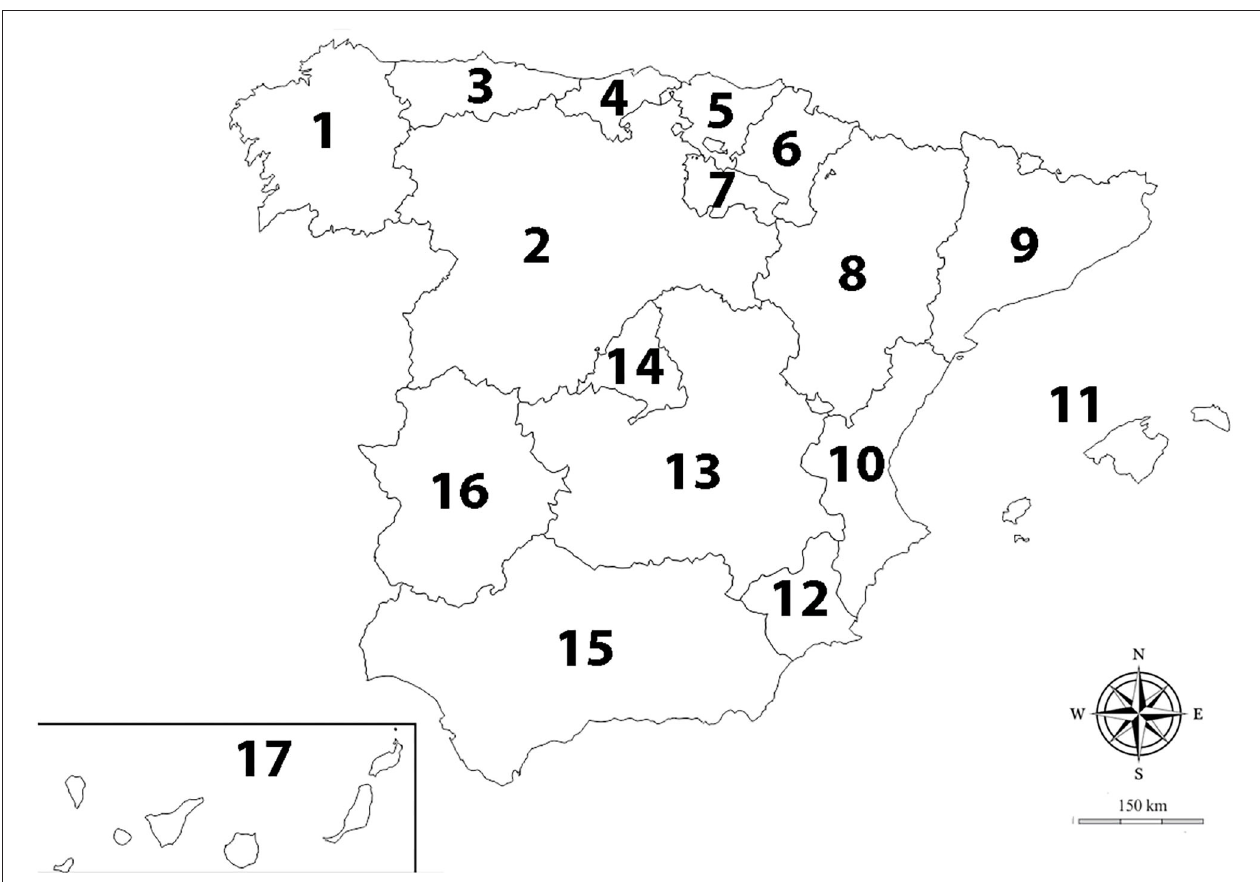
FIGURE 1 | Autonomous communities of Spain. (1) Galicia; (2) Castile and Leon; (3) Asturias; (4) Cantabria; (5) Basque Country; (6) Navarra; (7) La Rioja; (8) Aragon; (9) Catalonia; (10) Valencian Community; (11) Balearic Islands; (12) Murcia; (13) Castilla-La Mancha; (14) Madrid; (15) Andalusia; (16) Extremadura; (17) Canary Islands.